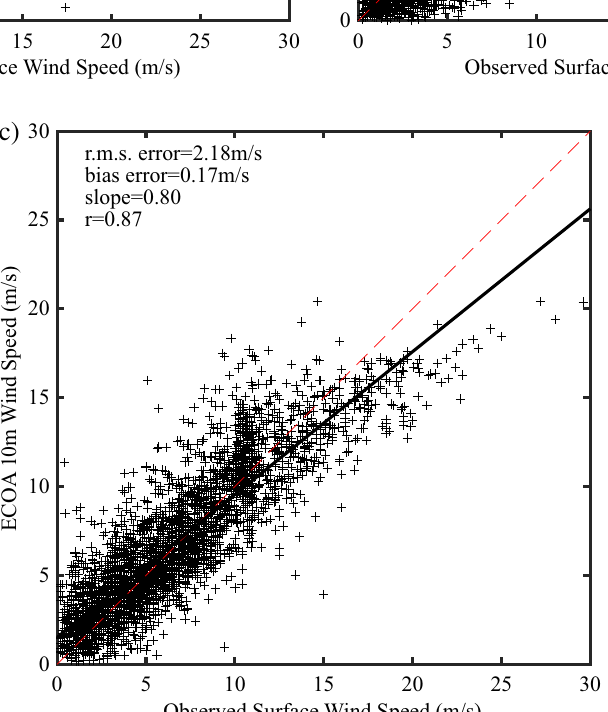
Figure 5. Scatterplots of the observed 6-hourly surface wind speed and the 10 m model wind speed at Hans Island. Results are shown for the: (a) eERA5, (b) ERA5 and (c) ECOA. Data from January 1 2016-September